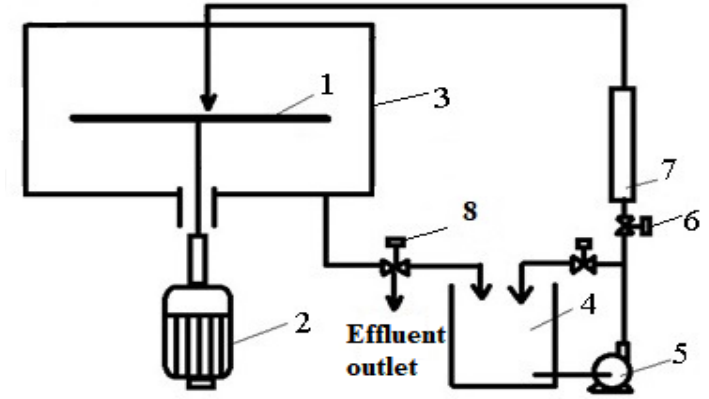
Figure 1. Experimental setup for the wastewater quality measurements. 1—rotating disc; 2—electric motor; 3—housing; 4—tank; 5—centrifugal pump; 6—adjusting tap; 7—flowmeter; 8—tap.